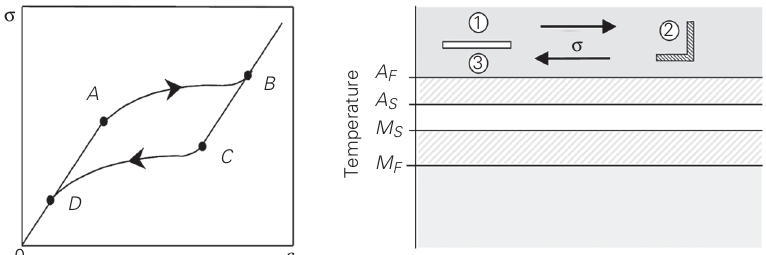
Figure 1. Pseudoelasticity. A S , A F and M S and M F = temperature at which the formation of austenite and martensite starts and ends, respectively. σ - ε = stress-strain curve. See text for explanation of